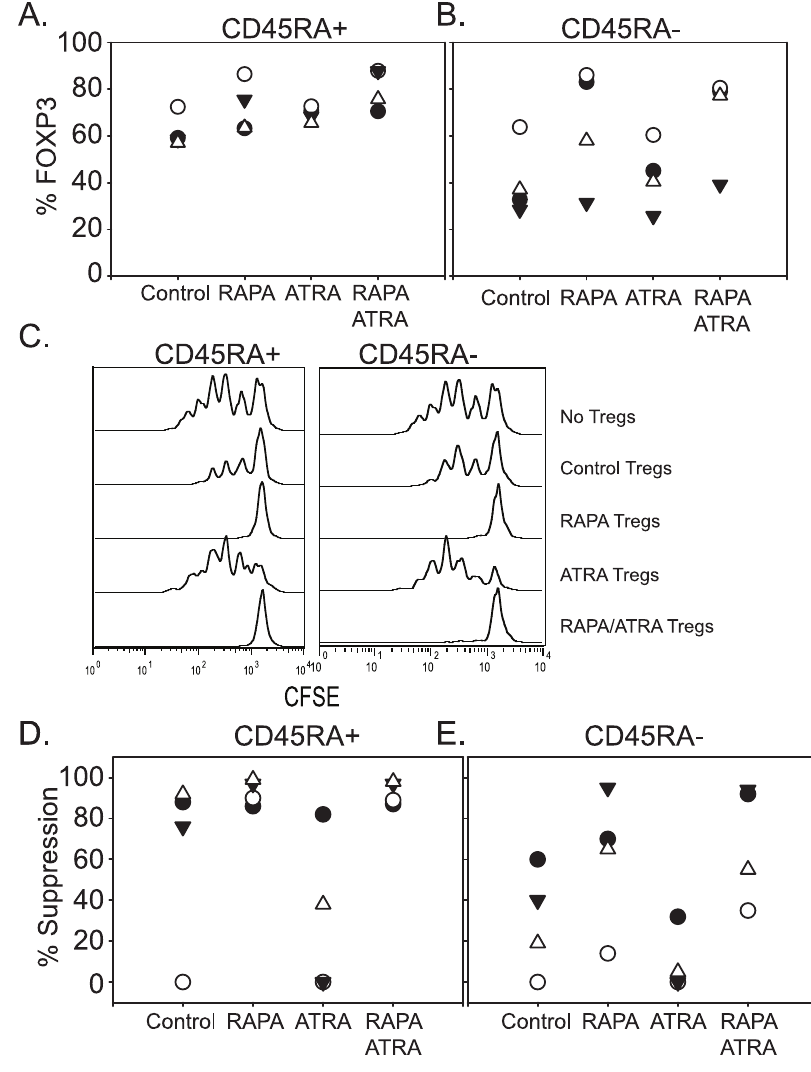
Figure 5. ATRA and RAPA affect Treg subsets equally. CD4 + CD25high CD45RA + ( A .) or CD4 + CD25high CD45RA 2 ( B .) populations were sort purified and expanded by anti-CD3 Ab-loaded K.64.86 aAPCs in the presence of 100 ng/ml of rapamycin, 10 nM ATRA or a combination of both. After 12–15 days of culture, FOXP3 expression was measured by flow cytometry. Data from 4 unique donors is displayed. C . Representative suppression data from a single donor using a 1:4 Treg to Effector ratio. D and E . Compiled suppression data from 4 donors (the donor in C. is the closed triangle).